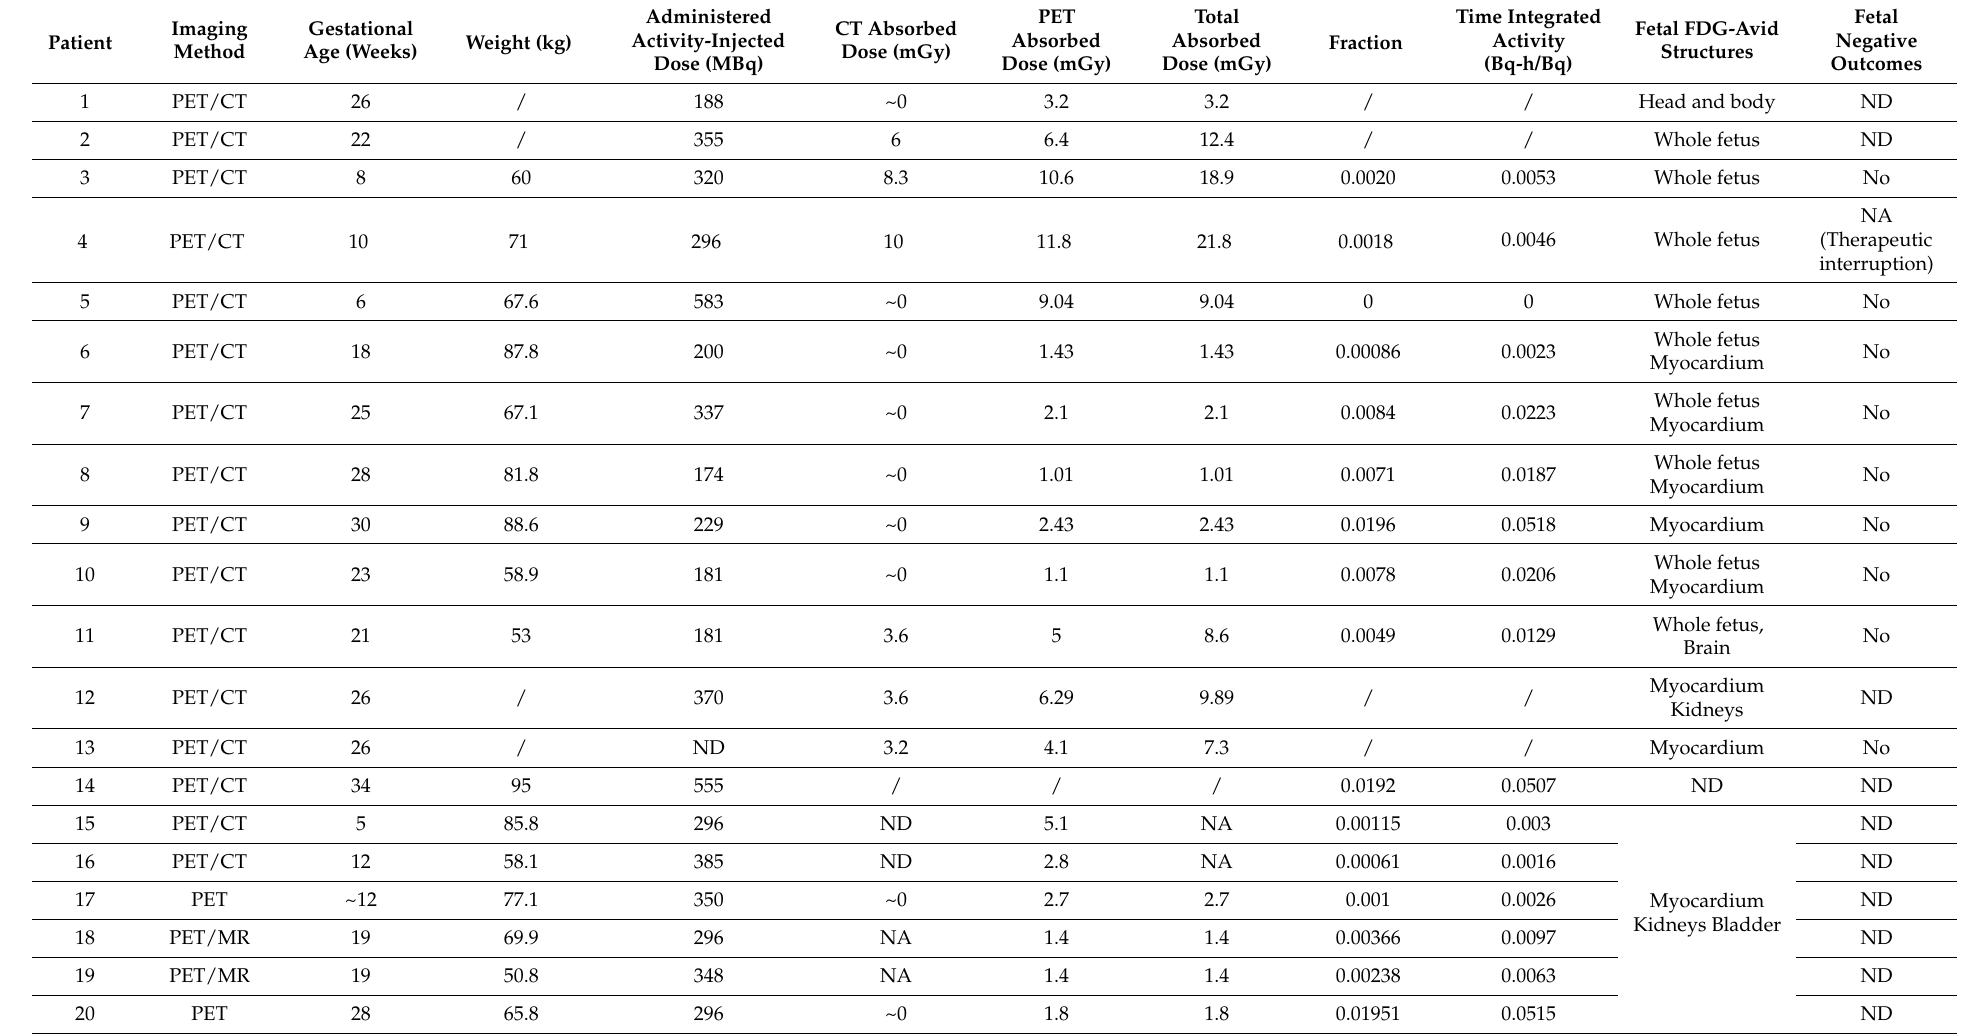
Table 2. Characteristics of patients, nuclear dosimetric data, fetal FDG-avid structures and